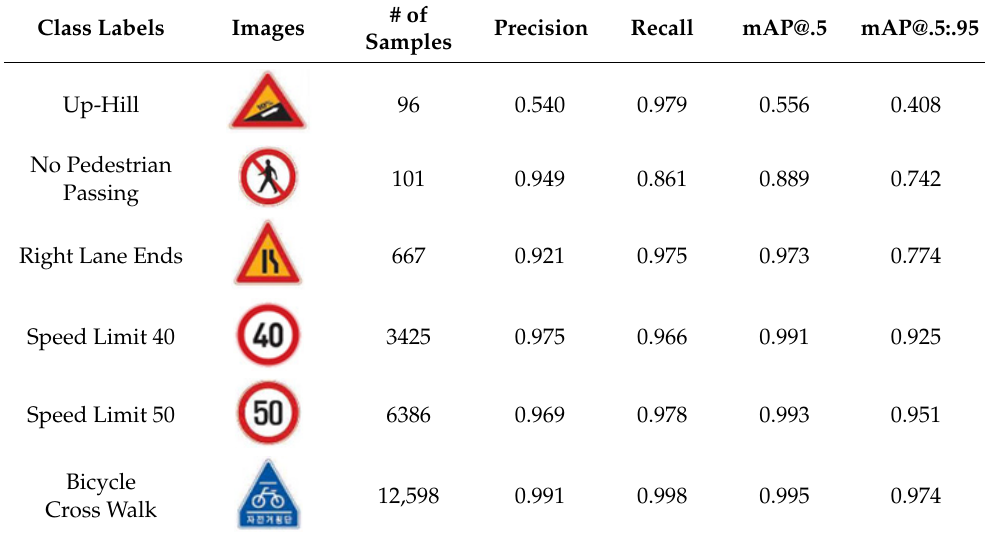
Table 10. Recognition performances for each traffic sign class (sampled classes). Class labels